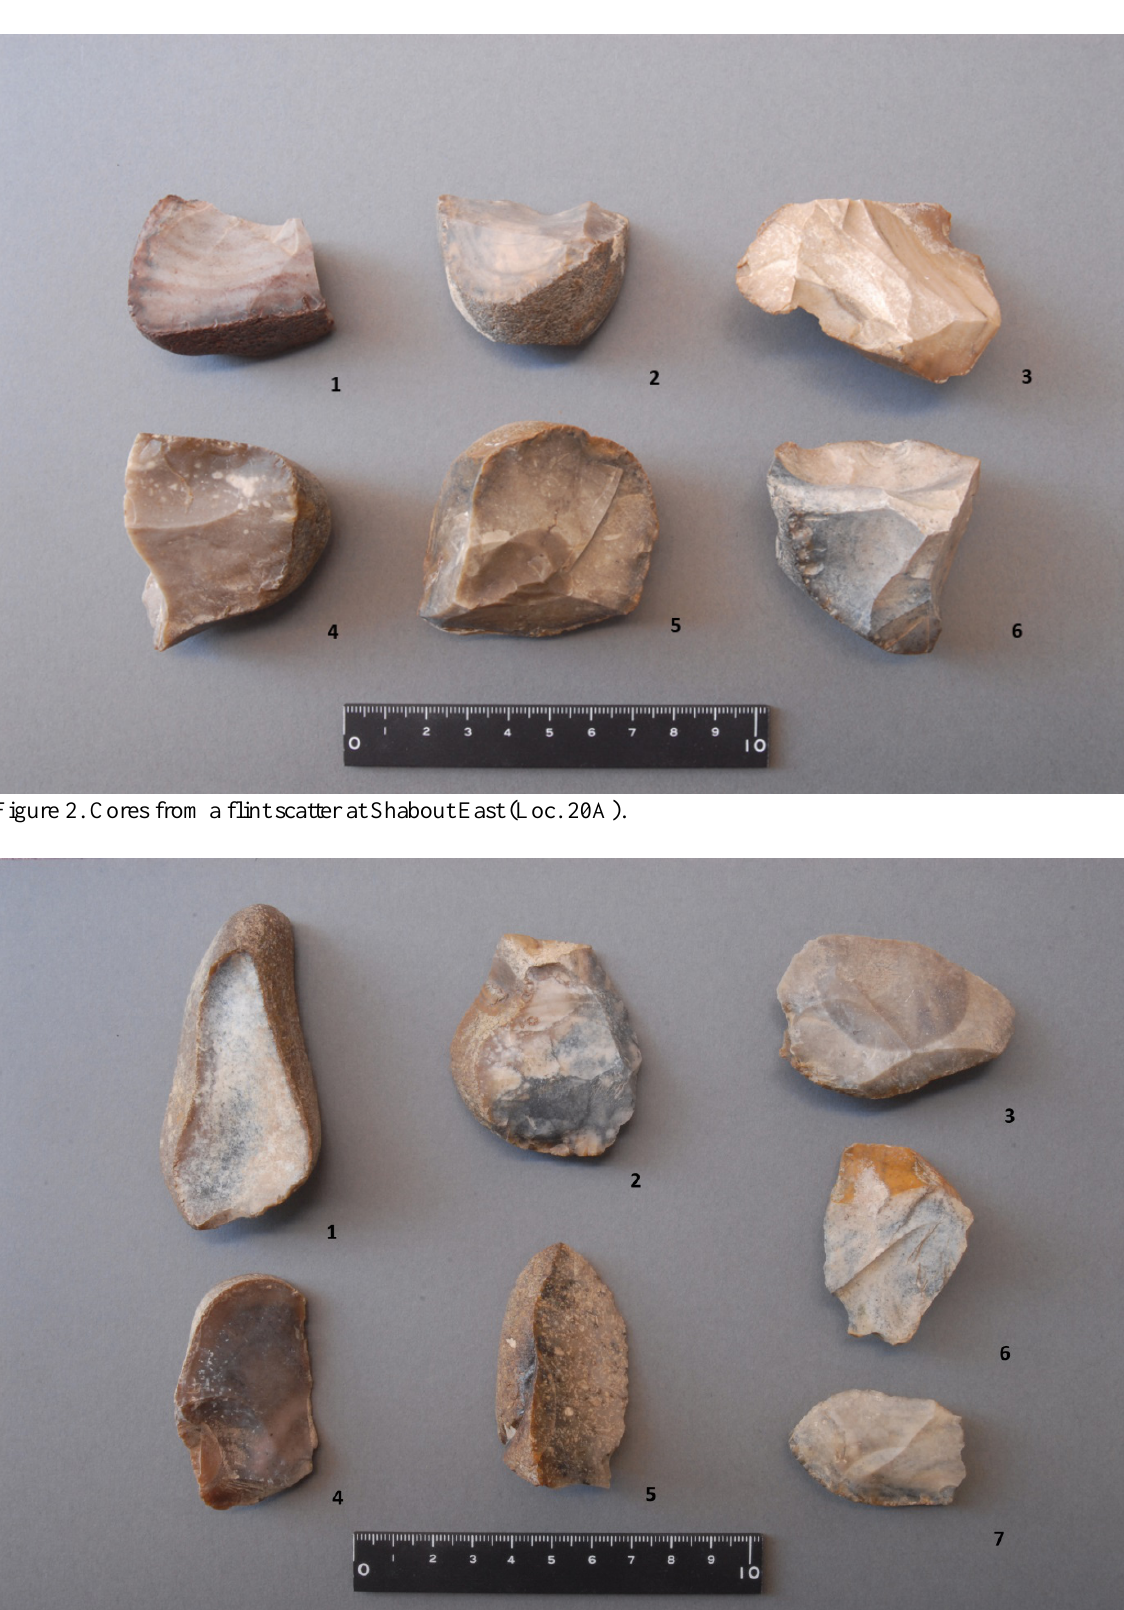
Journal of Lithic Studies (2014) vol.1, nr. 1, p. 197-212 doi:10.2218/jls.v1i1.781